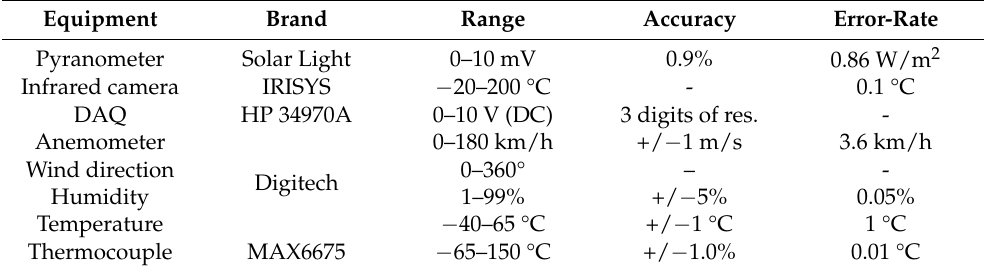
Table 5. Technical specifications of the measurement instruments and their error rates (per unit).